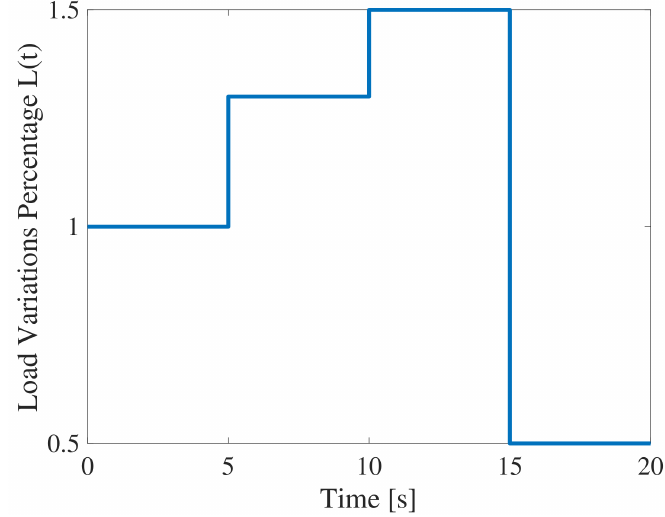
Figure 6. Load Variations Percentage